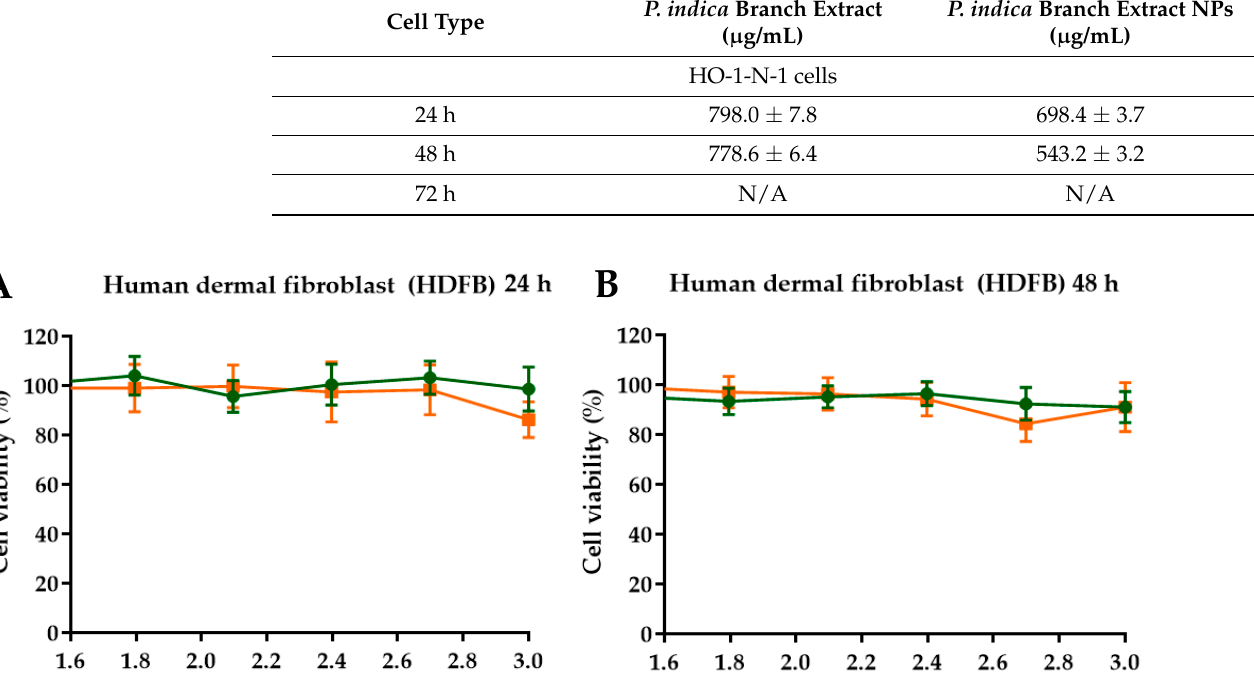
Figure 6. Effect of P. indica branch extract and NPs on HO-1-N-1 cell viability after incubation for ( A ) 24 ( B ) 48 and ( C ) 72 h. The data represent mean ± SD of three experiments.